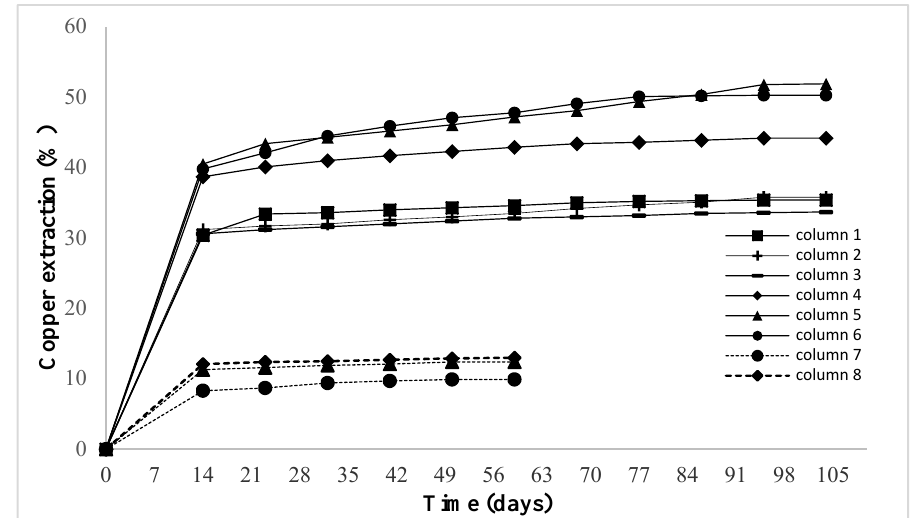
Figure 4. Extractions of copper during agglomeration ‐ curing and leaching stages. Black ( ˗ ) and dotted ( ‐‐‐ ) lines correspond to the experiments performed at 32.9 and 14.5 °C in columns, respectively. Discontinuous vertical lines show the division between the agglomeration ‐ curing and leaching stages.